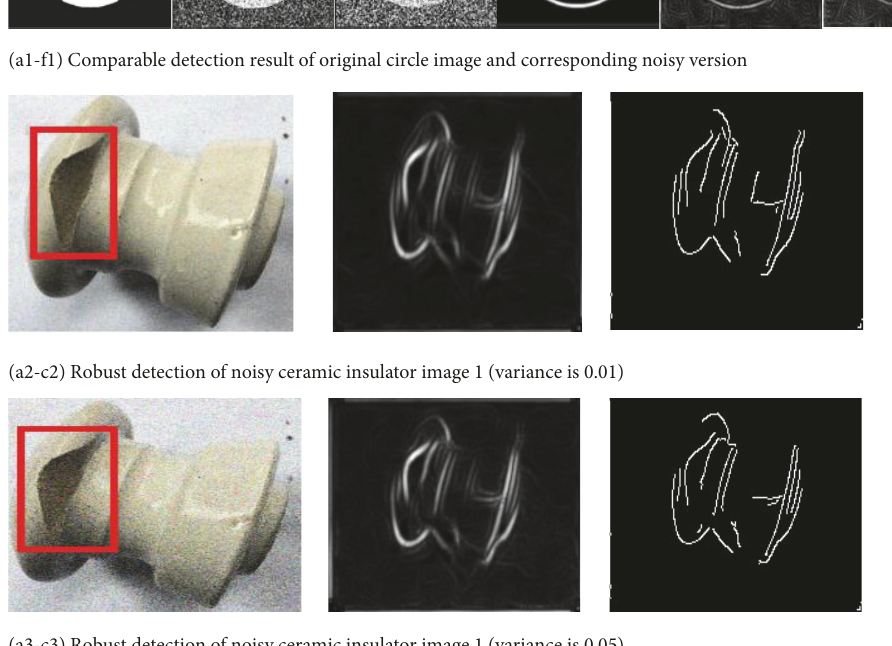
Figure 8: Robust detection test of original circle and different noisy